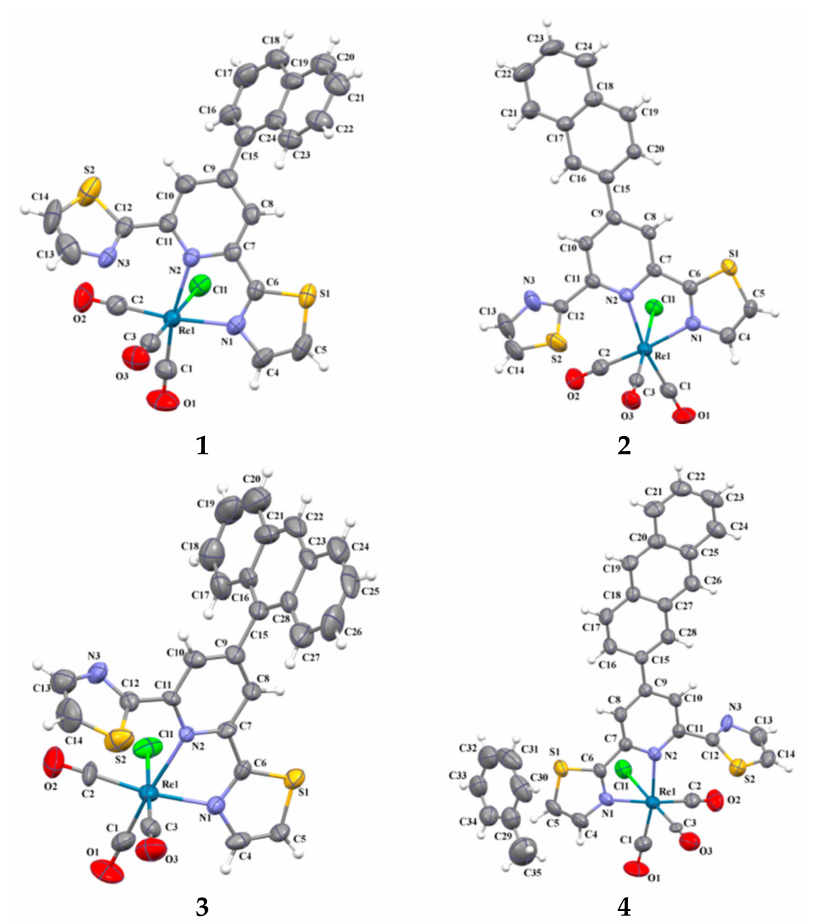
Figure 1. The molecular structure of 1 – 4 with the atom numbering and thermal ellipsoids set at 50% probability for non-hydrogen